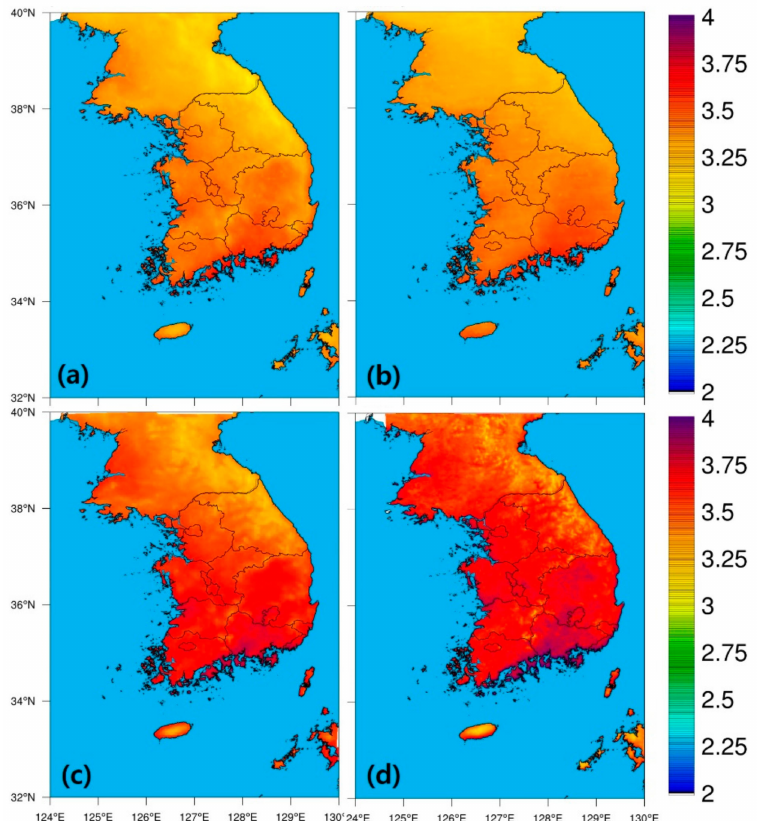
Figure 8. Horizontal distribution of annual mean of daily total irradiance (kWh m − 2 d − 1 ) that is estimated by the UASIBS–KIER model with GMS–5 ( a ), GOES–9 ( b ), MTSAT–1R/2 ( c ) and COMS ( d